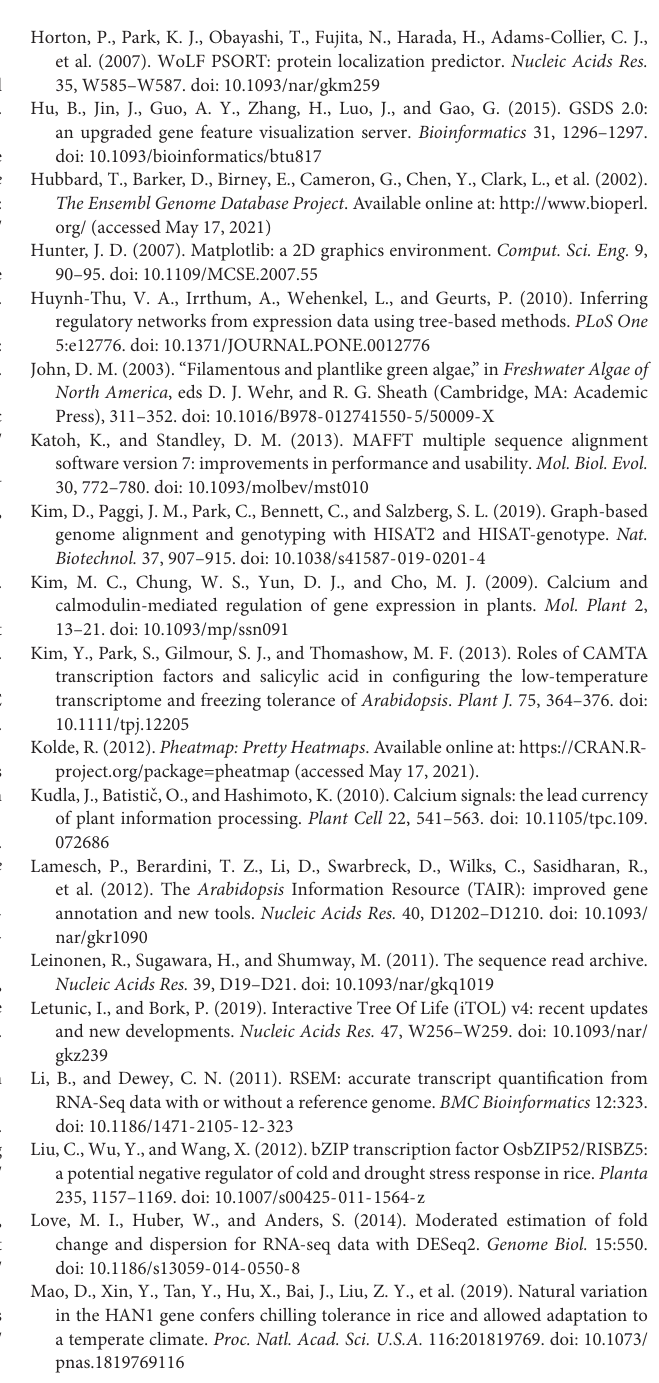
Supplementary Figure 3 | Expression level of CAMTA genes in 12 species. Supplementary Table 1 | A total of 112 plant genomes for subsequent analysis. Supplementary Table 2 | The transcription data for subsequent analysis. Supplementary Table 3 | A total of 465 identified CAMTA proteins.